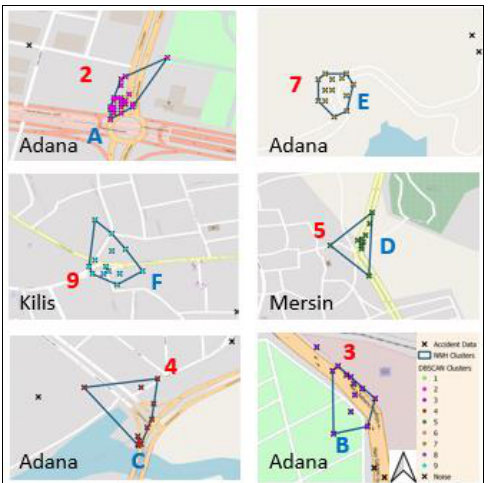
Figure 6. Mersin Region Speed-related Accident Clusters Map of 2018-2019 (NNH and DBSCAN are overlaid)